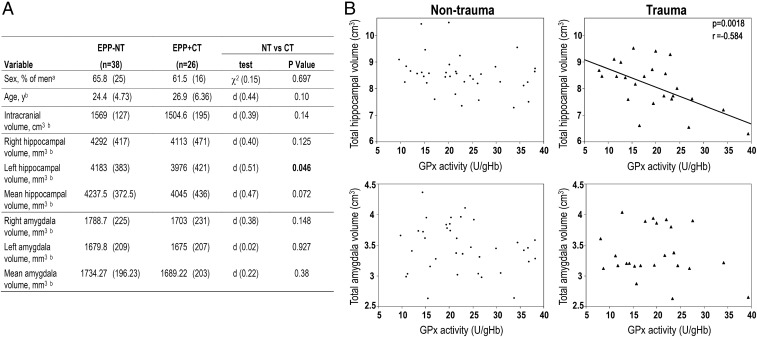
Smaller hippocampus is associated with a more oxidized status in blood of traumatized patients. (A) Demographic and anatomical characteristics of the subgroup of EPP with imaging scans. Data are presented as a percentage (n) (a) and as the mean (SD) (b). P < 0.05 is indicated in bold. (B) Scatterplots illustrating the relation between blood GPx activity [units per gram of Hb (U/gHb)] and total hippocampal volume (Top) or total amygdala volume (Bottom) in EPP−NT (Left) and EPP+CT (Right). Pearson’s correlation coefficient indicated a negative correlation between hippocampal volume and GPx activity in EPP+CT (r = 0.58, P = 0.0018). No correlation was detected in EPP–NT or with the amygdala.